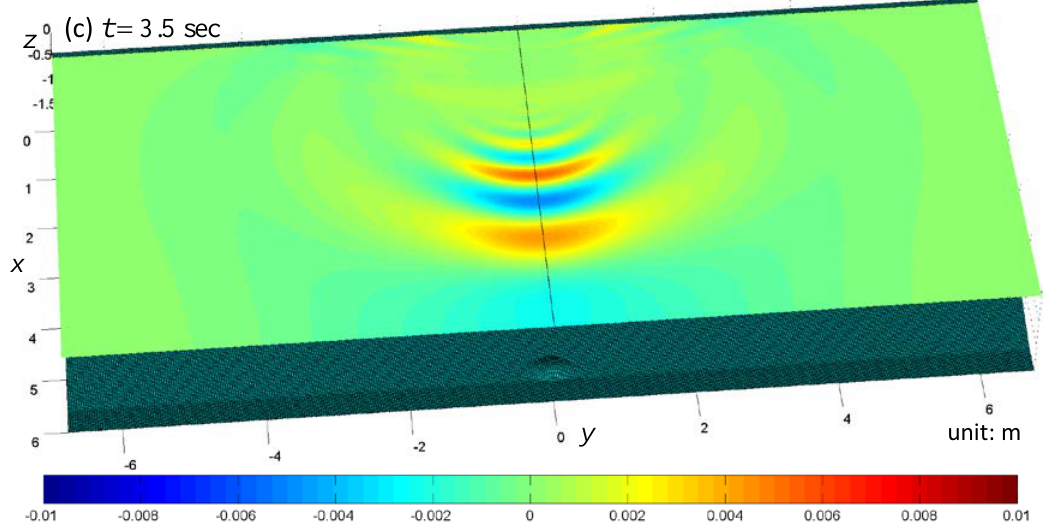
Figure 15. Snapshots of the free surface elevation in case 3 in a wider wave flume. ( a ): t = 0.5 sec; ( b ): t = 2.0 sec; ( c ): t = 3.5